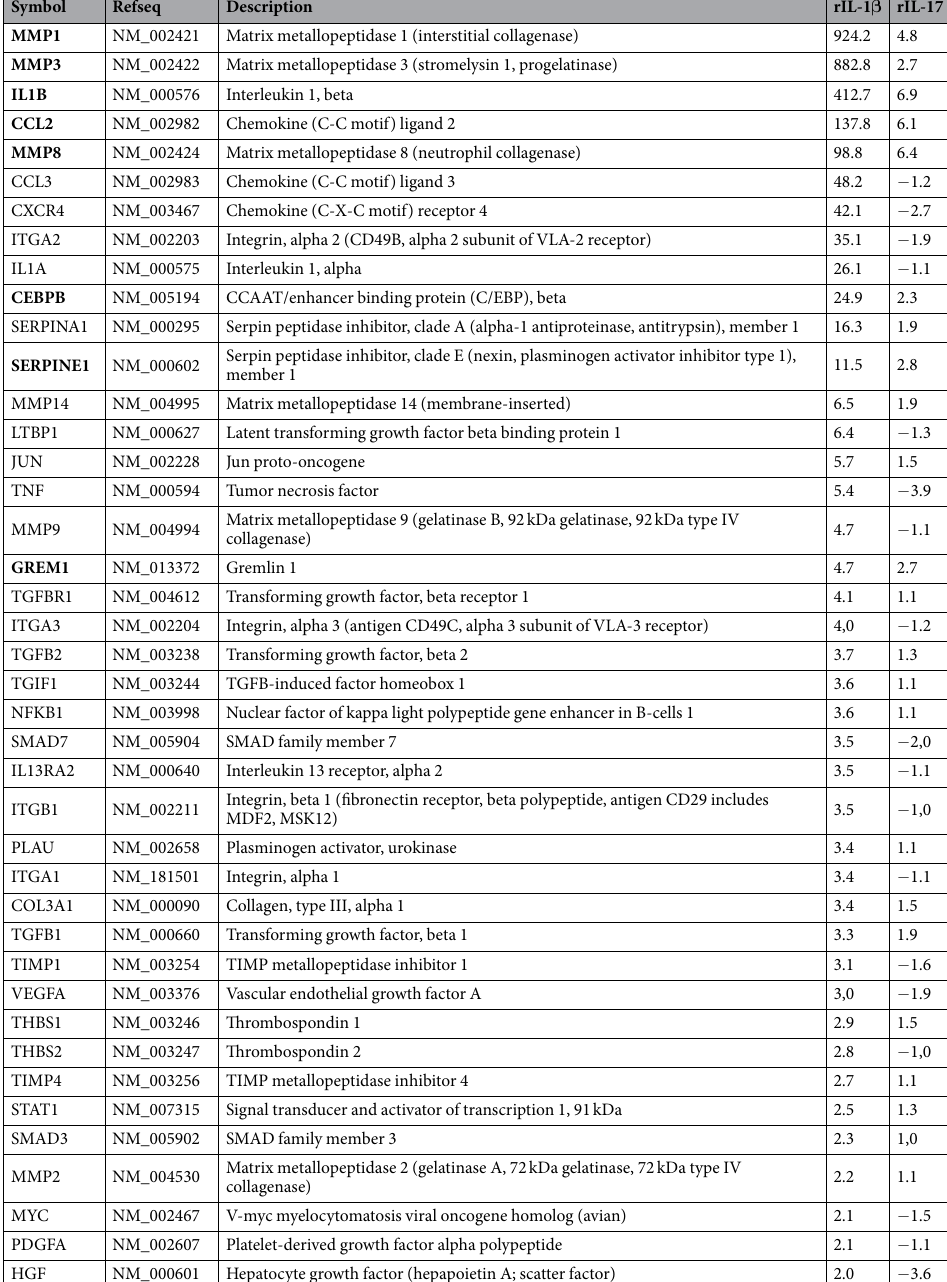
Table 1. PCR array analysis of 84 genes related to fibrosis and inflammation in primary human pre-adipocytes. Cells were treated or not by recombinant rIL-1 β (10 ng/mL) or rIL-17 (10 ng/mL). The data show fold changes over untreated control cells for 41 genes up-regulated by rIL-1 β with a 2-fold threshold. Bold labeling identifies 8 genes up-regulated by rIL-17 in the same